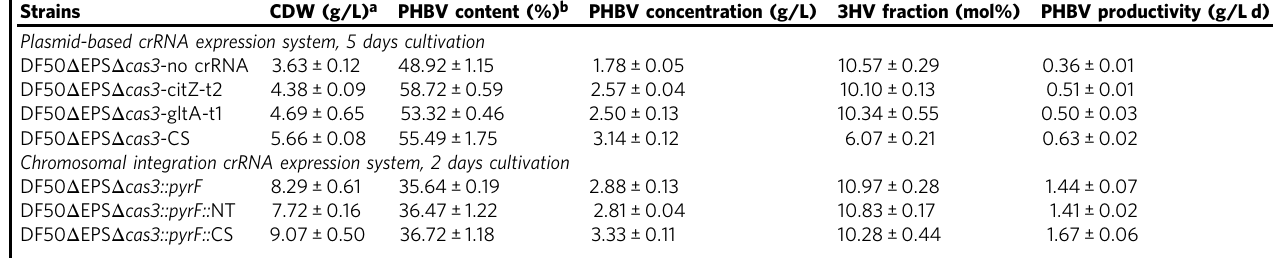
All data are expressed as mean±standard deviations from three independent experiments and strains were cultivated in MG medium for 5 or 2 days. a CDW, dry weight of the cell (in grams) produced per liter of culture. b PHBV content, the weight percent of PHBV in